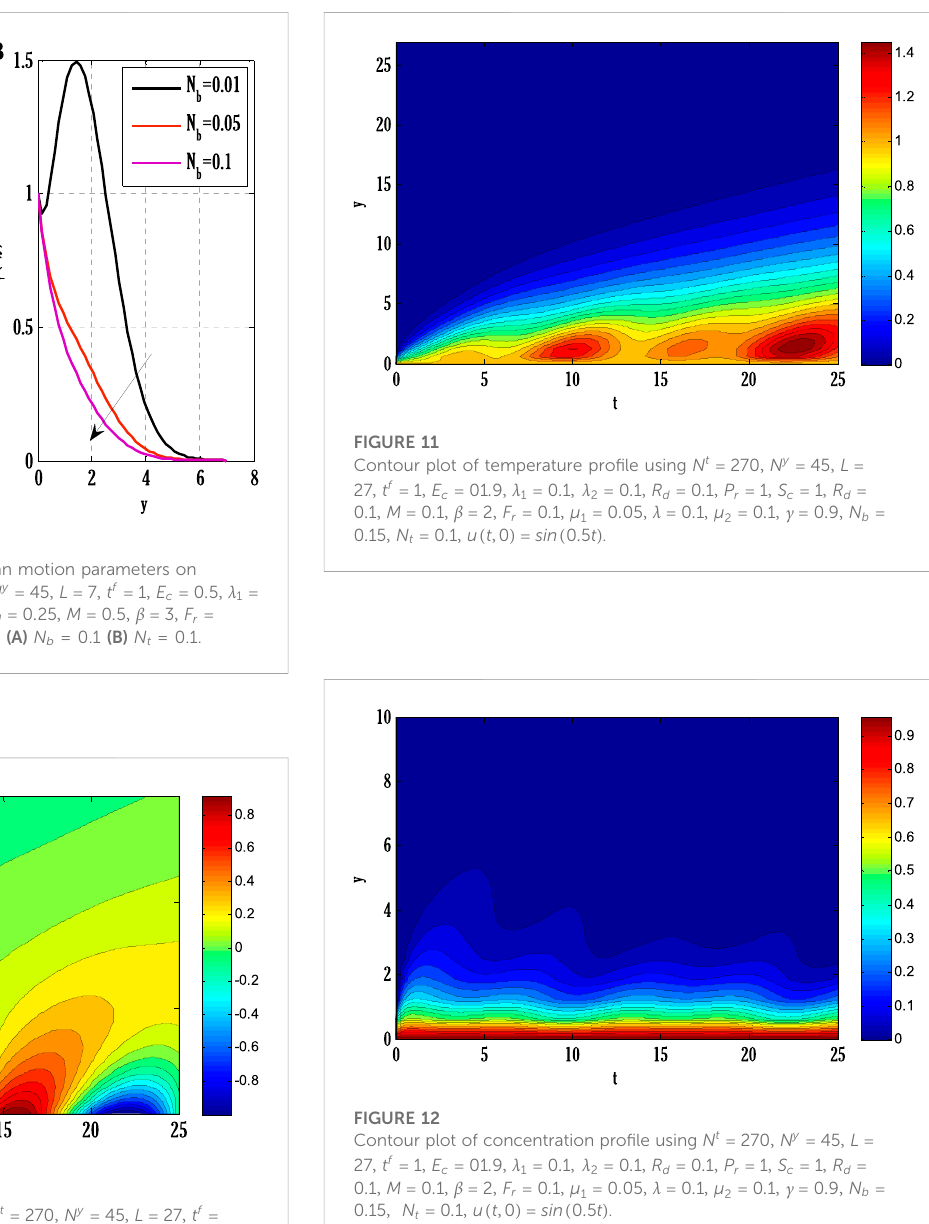
FIGURE 10 Contour plot ofvelocity pro fi le using N t (cid:2) 270 , N y (cid:2) 45 , L (cid:2) 27 , t f (cid:2) 1 , E c (cid:2) 01 . 9 , λ 1 (cid:2) 0 . 1 , λ 2 (cid:2) 0 . 1 , R d (cid:2) 0 . 1 , P r (cid:2) 1 , S c (cid:2) 1 , R d (cid:2) 0 . 1 , M (cid:2) 0 . 1 , β (cid:2) 2 , F r (cid:2) 0 . 1 , μ 1 (cid:2) 0 . 05 , λ (cid:2) 0 . 1 , μ 2 (cid:2) 0 . 1 , γ (cid:2) 0 . 9 , N b (cid:2) 0 . 15 , N t (cid:2) 0 . 1 , u ( t , 0 ) (cid:2) sin ( 0 . 5 t ) . pro fi le due to the Casson parameter is the consequence of the diffusion coef fi cient reduction affecting the fl ow ’ s velocity. The rising values of the magnetic parameter diminish the fl ow ’ s velocity because the generation of Lorentz force in electrically conducting fl uid resists the fl ow ’ s velocity, and consequentlyvelocityofthe fl owdrops.Theeffectoftheporosityparameter and inertia coef fi cient on the fl ow ’ s velocity is discussed in Figure 4. Velocity pro fi le de-escalates by enhancing the porosity parameter and inertia coef fi cient. Since the fl uid ’ s viscosity resists the fl ow ’ s velocity, increasing the porosity parameter increases the fl uid ’ s viscosity and reduces the velocity pro fi le. Also, the velocity of the fl ow de-escalates by enhancing theinertia coef fi cient; thisisthe case whenthedrag forceescalates, resulting in a decline in the fl ow ’ s velocity. The impact of thermal and solutal mixed convection parameters on the velocity pro fi le is portrayed in Figure 5.